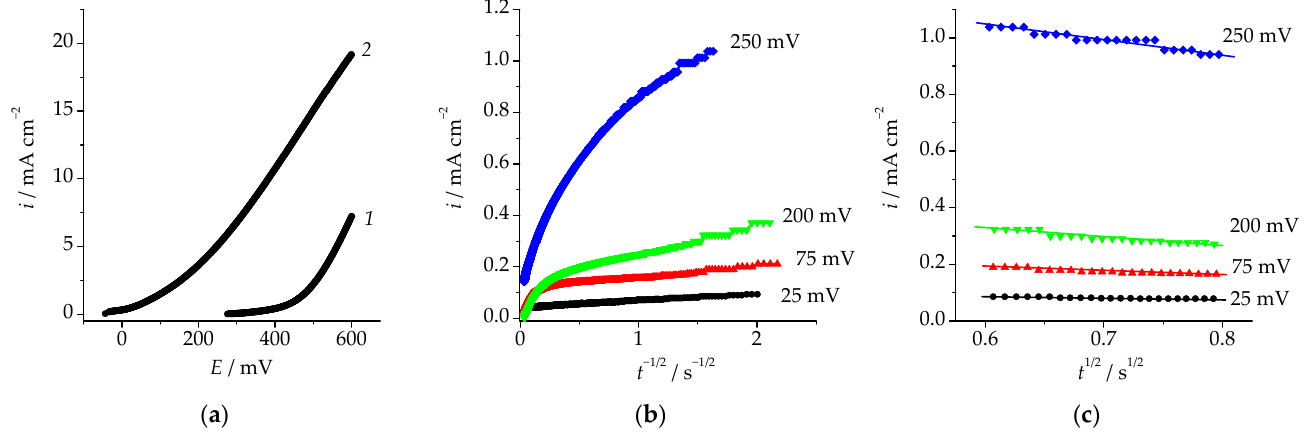
Figure 5. ( a )—Polarization curves on the unmodified (1) and subjected to selective dissolution (2) Cu 85 Pd 15 alloy in 1 M HCOOH + 0.05 M H 2 SO 4 ; ( b )—Cottrell chronoamperograms of the electro-oxidation of formic acid on the Cu 85 Pd 15 alloy anodically modified at various potentials; ( c )—initial regions of the electro-oxidation chronoamperograms of НСООН obtained from the Cu 85 Pd 15 alloy anodically modified at various potentials and linearized in mixed-kinetic coordinates. Selective dissolution mode: q mod = 24 mC·cm − 2 and E mod = 630 mV.